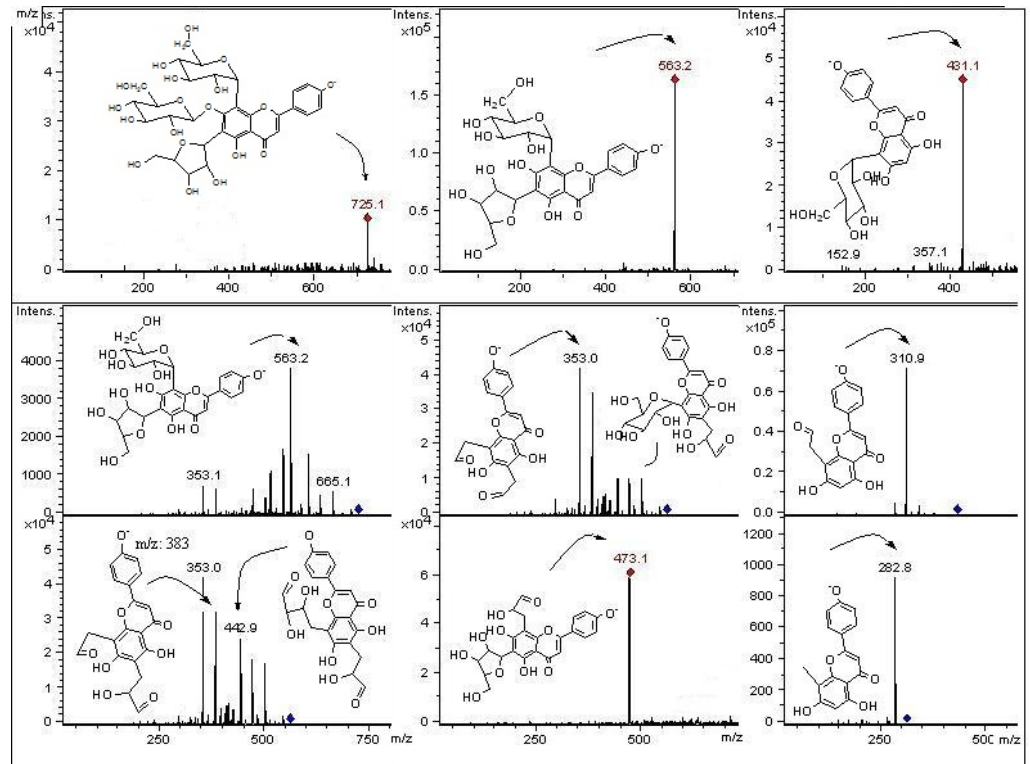
Figure 4. Structures, fragmentation, full ESI-MS and MS-MS spectra of peaks 1, 9, and